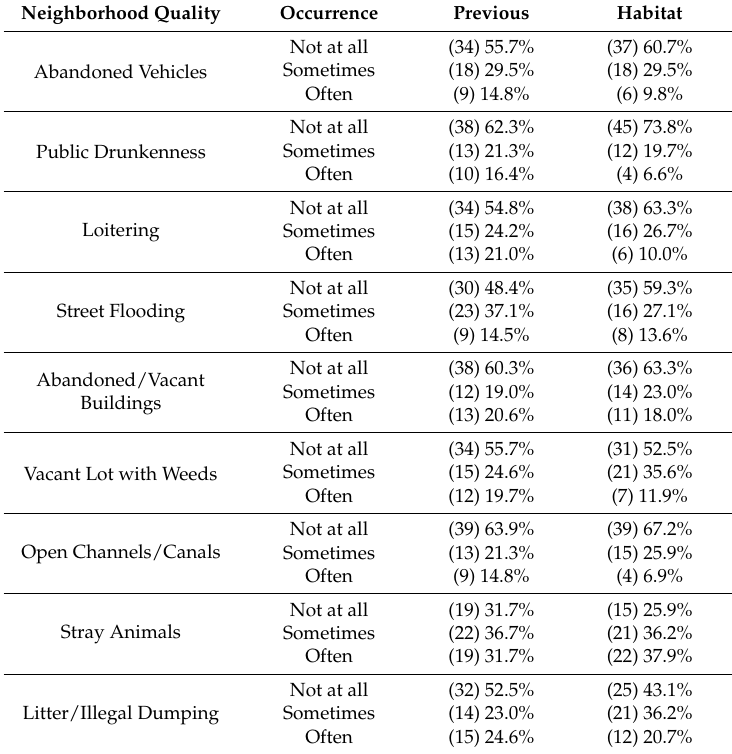
Perceptions of Respondents Regarding Quality of Their “Previous” and “Habitat” Neighborhood-Physical